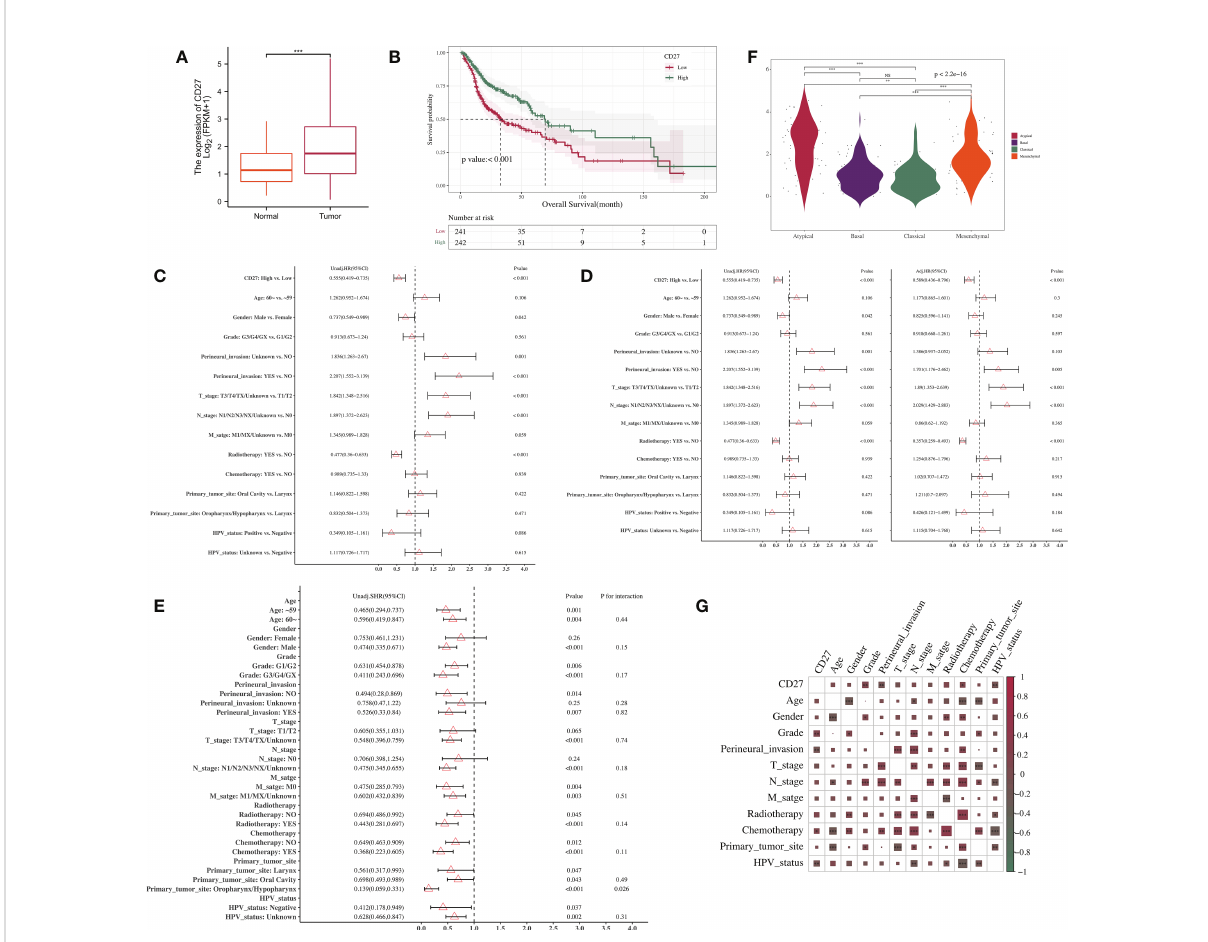
FIGURE 1 Association between gene expression level and clinical characteristics. (A) CD27 expression in normal and tumor tissues. (B) Correlations between CD27 expression and OS in HNSCC. (C) Univariate Cox regression analyses. (D) Multivariate Cox regression analyses. (E) Subgroup analysis and interaction test. (F) Subtype analysis. (G) Correlation analysis between CD27 expression and clinical parameters of HNSCC. ** p < 0.01, *** p < 0.001, NS, no signi fi